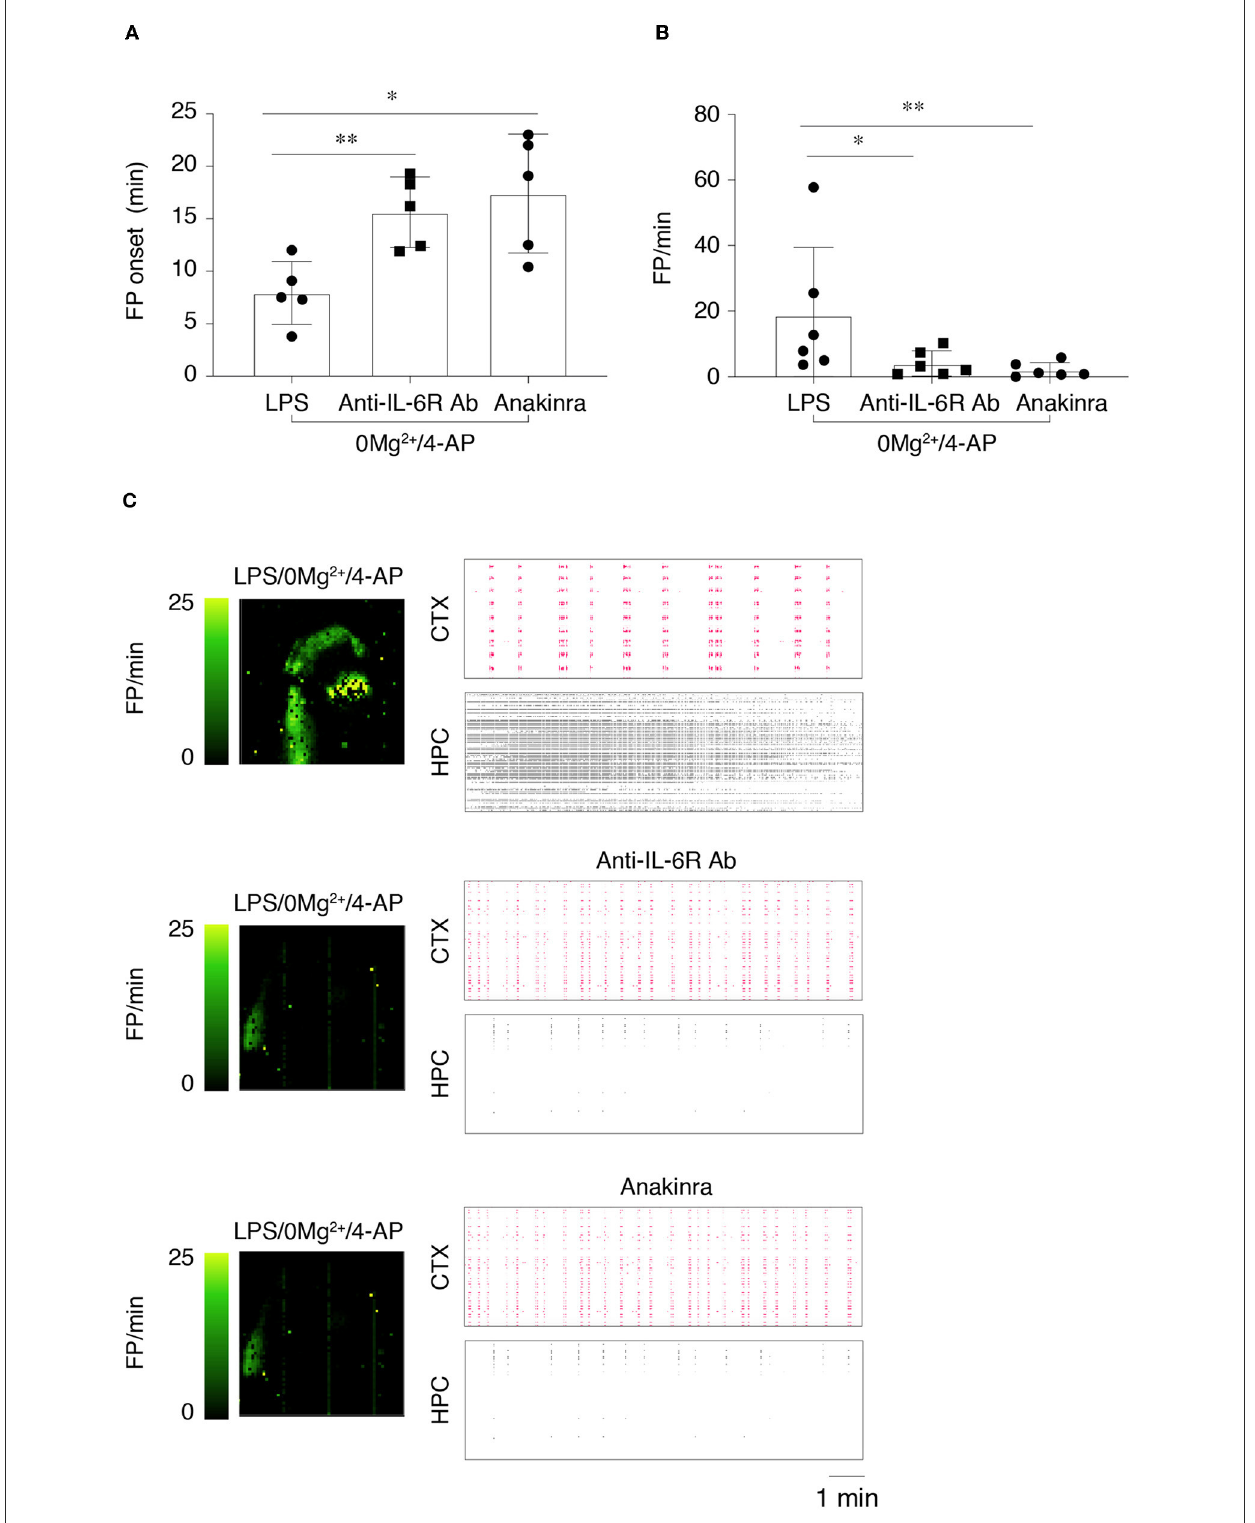
FIGURE5 Effects of anti-IL-6R antibody and anakinra on epileptiform activity in lipopolysaccharide-treated slices. (A, B) The onset of the first field potential (FP) event (A) and FP frequency (B) in the various experimental groups ( n = 6 slices/group). FP frequency was calculated during T2 (20–30min from the start of 0 Mg 2 + /4-AP perfusion). Slices were preincubated with aCSF containing LPS (10 µ g/ml for 30min, followed by 5min aCSF washout), then perfused in aCSF ± anti-mouse IL-6R Ab (100 µ M) or ± anakinra (1.3 µ M) for 15min followed by 0 Mg 2 + /4-AP ± drugs for 40min. * p < 0.05; ** p < 0.01 by Mann–Whitney test vs. respective control slices (aCSF, no added drugs). (C) Depicts representative activity maps (higher FP frequency corresponds to lighter green color) and raster plots in temporal cortex (CTX) and hippocampus (HPC) in slices perfused with 0 Mg 2 + /4-AP + LPS with or without the immunomodulatory